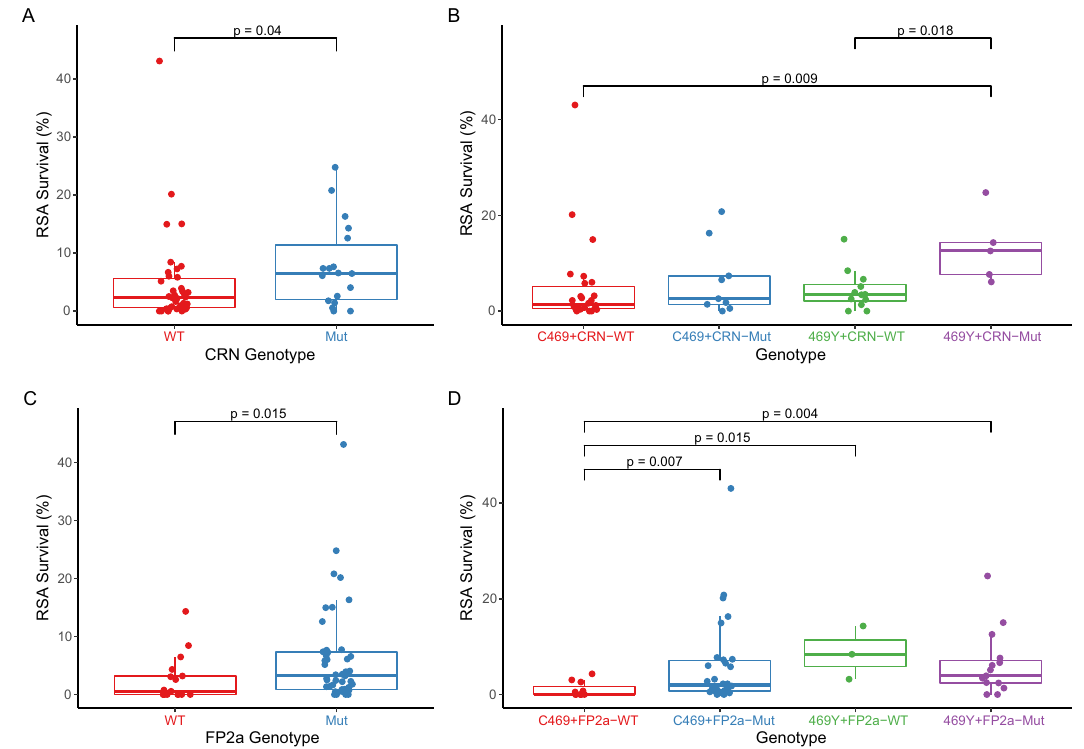
Fig. 4 | Ex vivo susceptibilities in parasites with different genotypes. Suscept- ibilitiestoDHAby RSAin parasiteswithdifferentPfK13,Pfcoronin(CRN; A , B ),and falcipain-2a(FP2a; C , D )genotypesareshown.Eachpointrepresentstheresultfora singleisolate( A n =38WT,18Mut; B n =26C469+CRN-WT,9C469+CRN-Mut,12 469Y+CRN-WT, 5 469Y+CRN-Mut; C n =17 WT, 47 Mut; D n =11 C469+FP2a-WT, 30 C469+FP2a-Mut, 3 469Y+FP2a -WT, 15 469Y+FP2a-Mut). PfK13 genotypes at codon 469 are indicated; mutant 469Y includes mixed isolates. P-values were